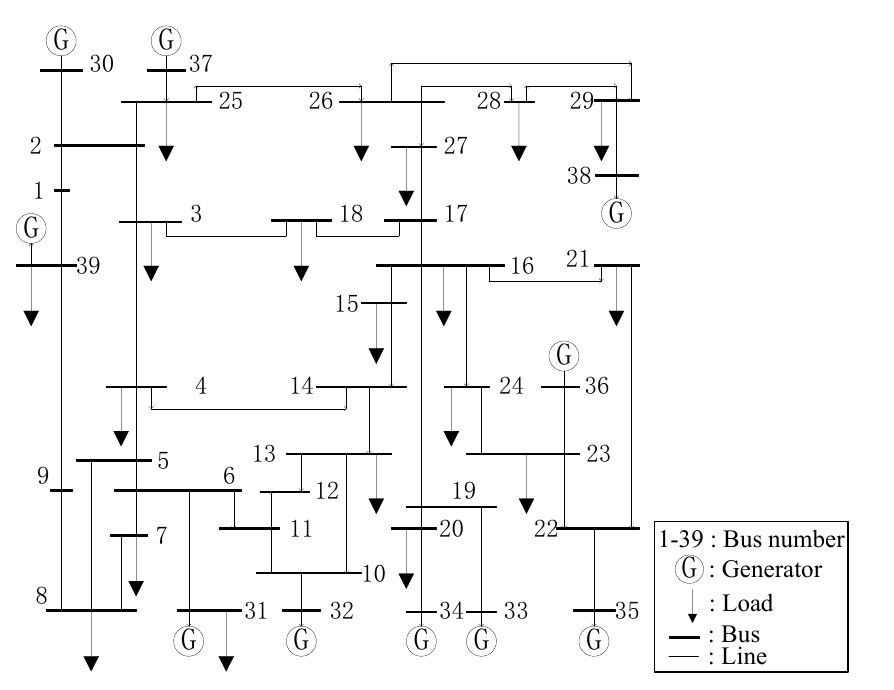
Figure 2. The topology of the IEEE-39 bus system. Table 1. Parameters of the new energy power generation under the IEEE-39 bus system.